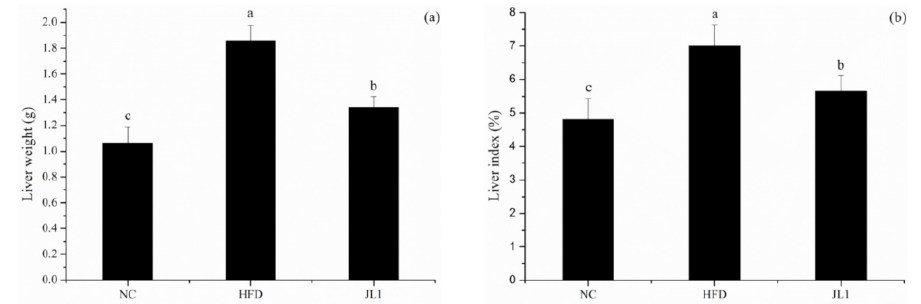
Figure 2. Effects of L. rhamnosus JL1 on the liver weight ( a ) and liver indexes ( b ) of mice. Each value represents the mean of 8 mice, and error bars indicate standard deviation ( ± SD). Different letters denote significant differences between different groups of mice ( p < 0.05).